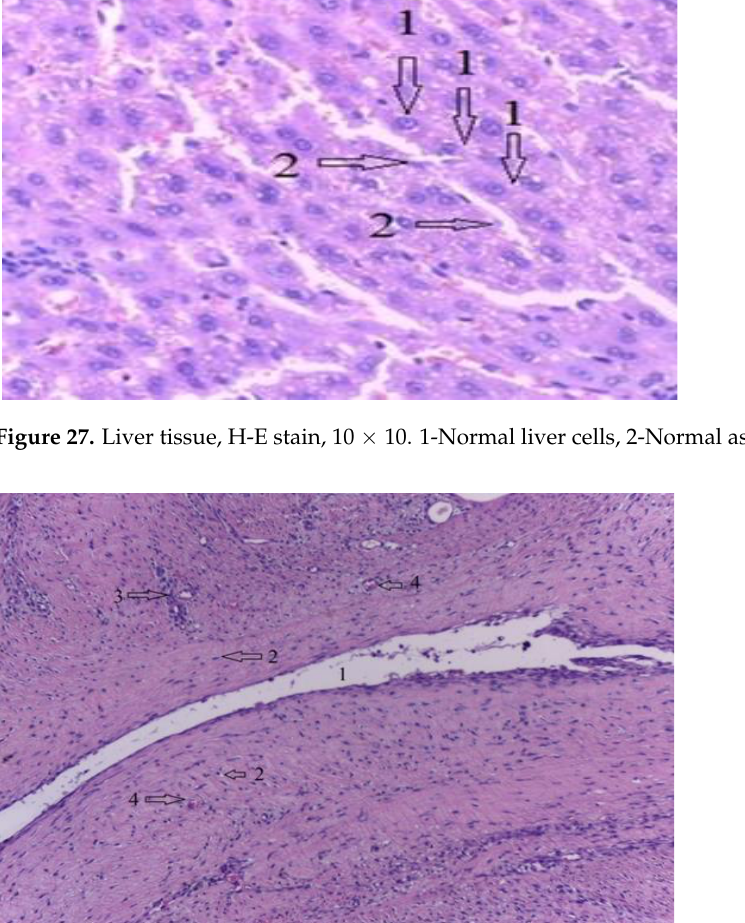
Figure 26. Kidney tissue; HE stain, 10 × 10. 1-Normal aspect of the glomeruli, 2-Normal collecting ducts.